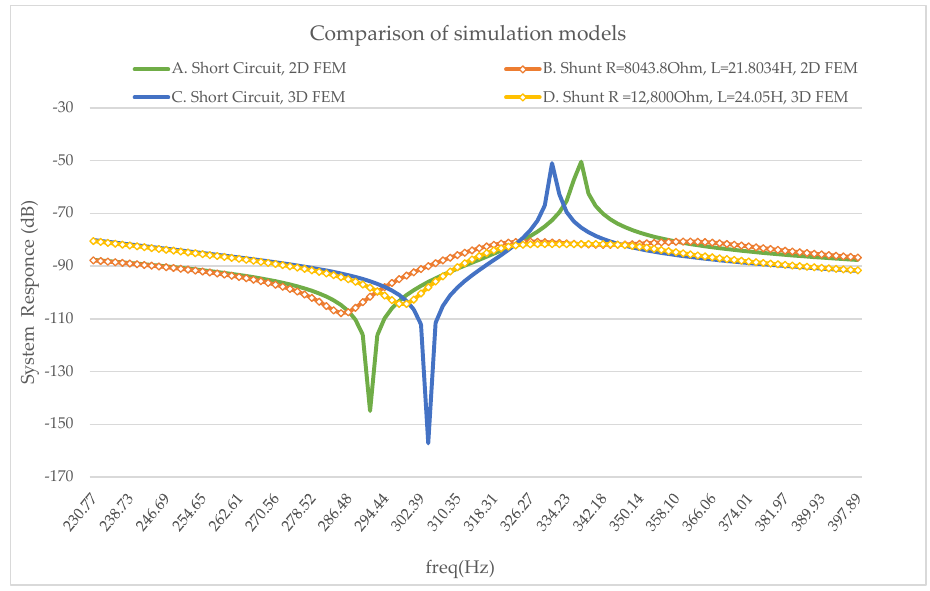
Figure 6. Simulated frequency response of the two models. Aluminum beam, Piezo. PIC151 and Optimal RL circuit values. A. Short circuit 2D FEM MATLAB, B. Shunt circuit R = 8043.8 Ohm L = 21.8034H 2D FEM MATLAB, C. Short circuit 3D FEM, D. Shunt circuit R = 12,800 Ohm L = 24.05 H 3D FEM.